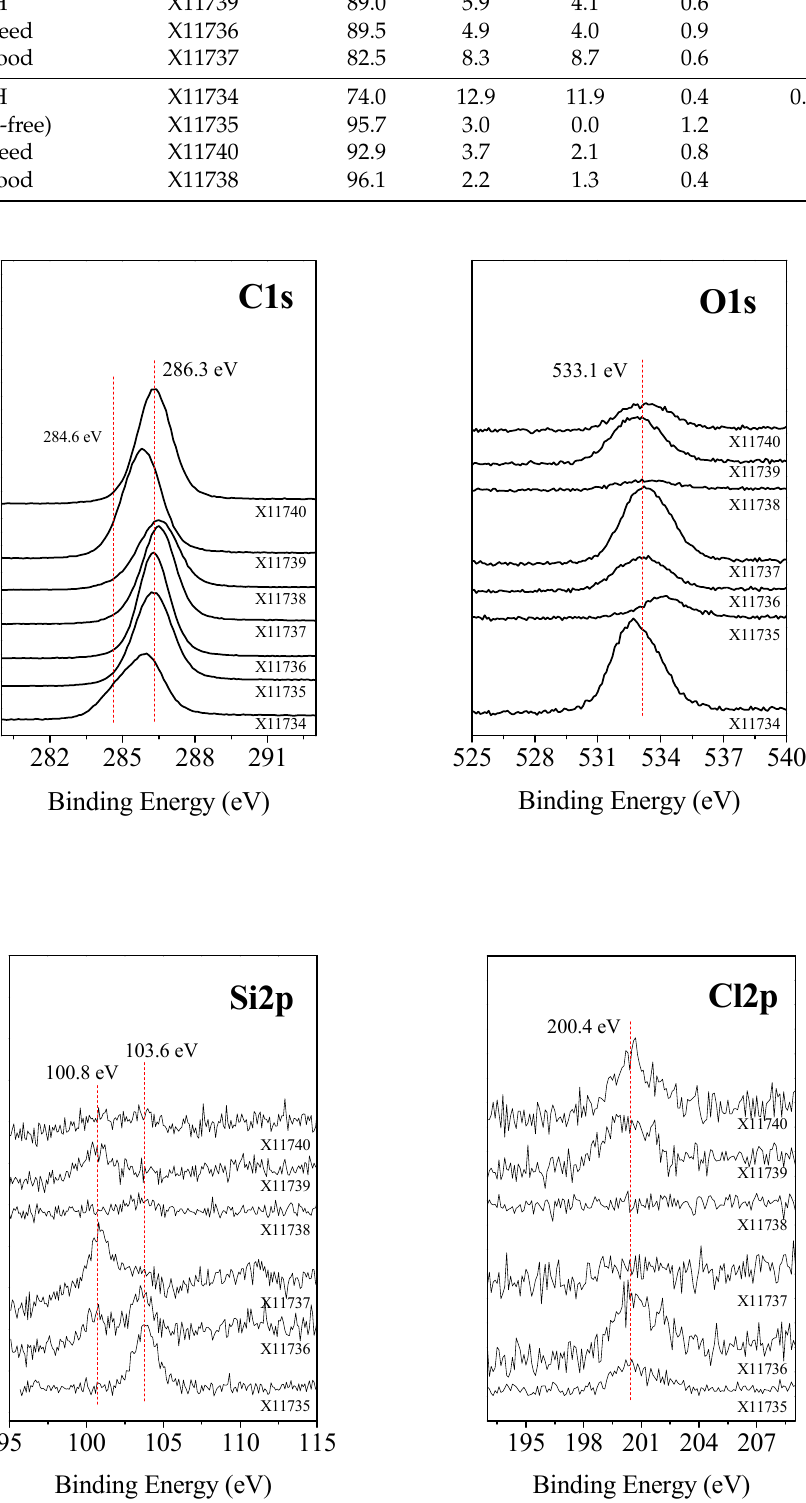
Figure 8. XPS spectra of PM 1 for three biomass types and two gasifying agents (O 2 /N 2 and O 2 /N 2 /CO 2 ).